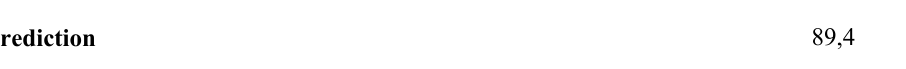
Forecasting results of logistic models of household characteristics affecting household hiring in the harvest Prediction True prediction Observation Hiring labor of household percentage 1.00 0.00 Hiring labor in the harvest 1.00 338 True percentage of overall prediction 89,4 Source: Survey data of the